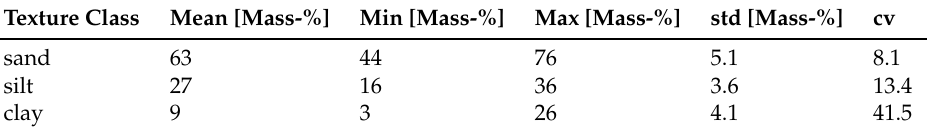
Table 2. Descriptive statistics of soil samples.